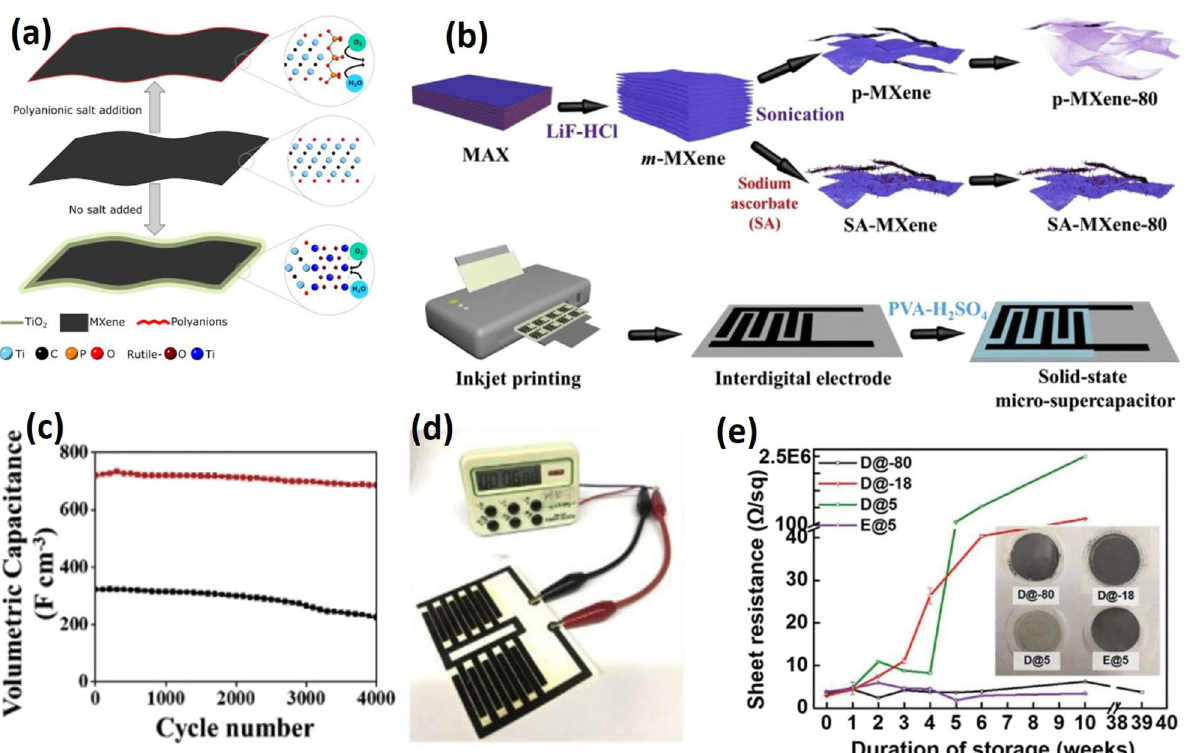
Fig. 14 Different synthesis protocols to get oxidation resistive MXenes. a Schematic diagram of edge capping of MXene sheets by polyanions. The middle fl ake is representative of an as-synthesized MXene fl ake. The top fl ake shows capping of MXene edges with polyanions to protect it from oxidation, while the bottom fl ake shows a bare edge that undergoes oxidation over prolonged exposure to water and air. Reprinted with permission from 159 . b Graphical diagram of the synthesis of stable SA-MXene composite and solid-state m-SCs manufactured by inkjet printing of the SA-MXene. c , d Cycling stability performance at a constant current of 1 A g − 1 of the p-MXene and SA- MXene-based supercapacitors. a – d used with permission from Elsevier B.V./Wu 119 . e During different storage time, the sheet resistances of Ti 3 C 2 T x fi lms for 10 weeks in D@-80, D@-18, D@5, and E@5. Including the calculated sheet resistance of Ti 3 C 2 T x stored for 39 weeks at − 80 °C. The inset displays optical images of Ti 3 C 2 T x fi lms acquired from MXene ’ s vacuum fi ltration solutions after 5 weeks of freezer storage at D@-18,